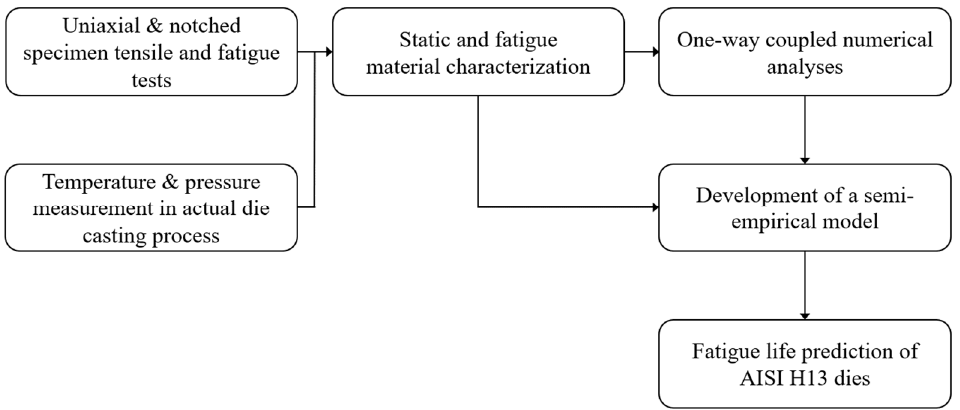
Figure 1. Fatigue life prediction procedures of AISI H13 die casting die.